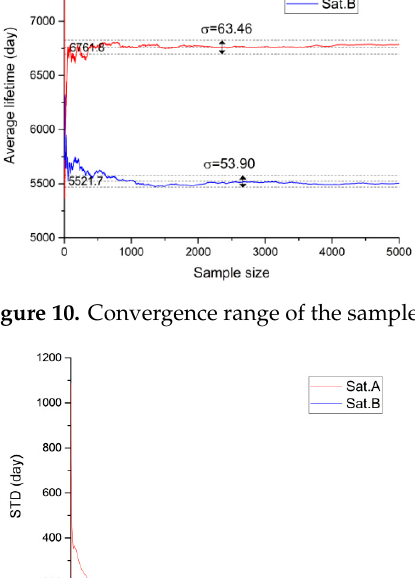
Figure 11. Convergence range of the standard deviation (STD).